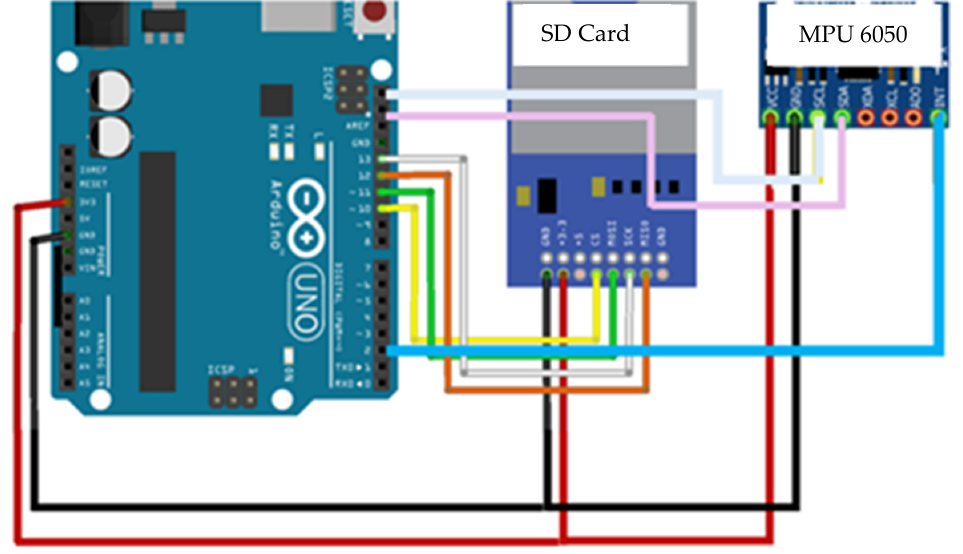
Figure 1. Accelerometer wiring schematic diagram.